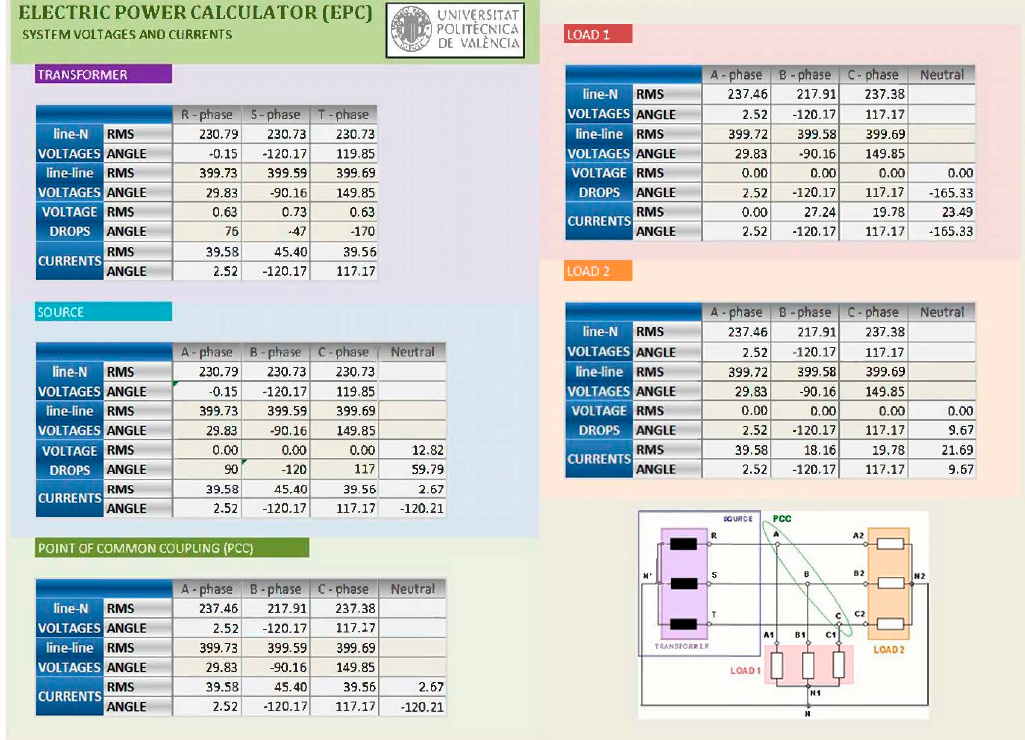
Figure 4. Screen of “System Voltages and Currents”.